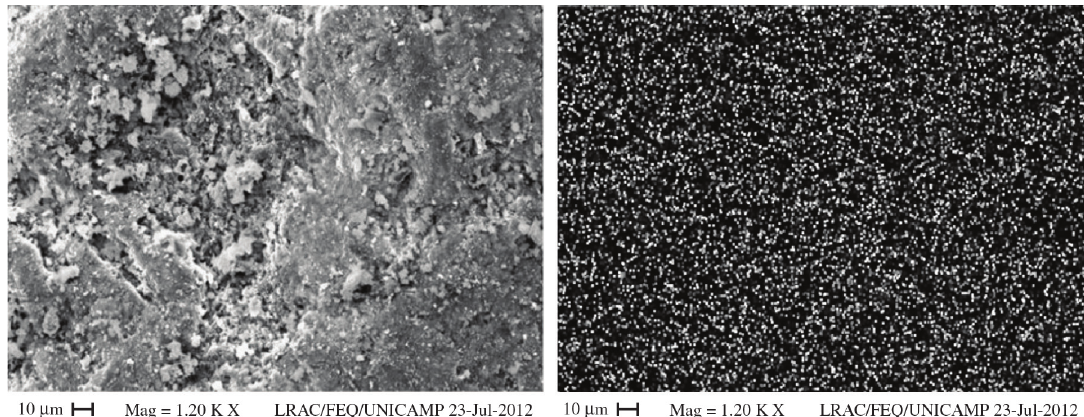
Figure 6. Metal mapping on Fluidgel TACal clay (dp = 0.855 mm) with 1200×amplified. The dots in micrograph right represent adsorbed lead on Fluidgel TACal.